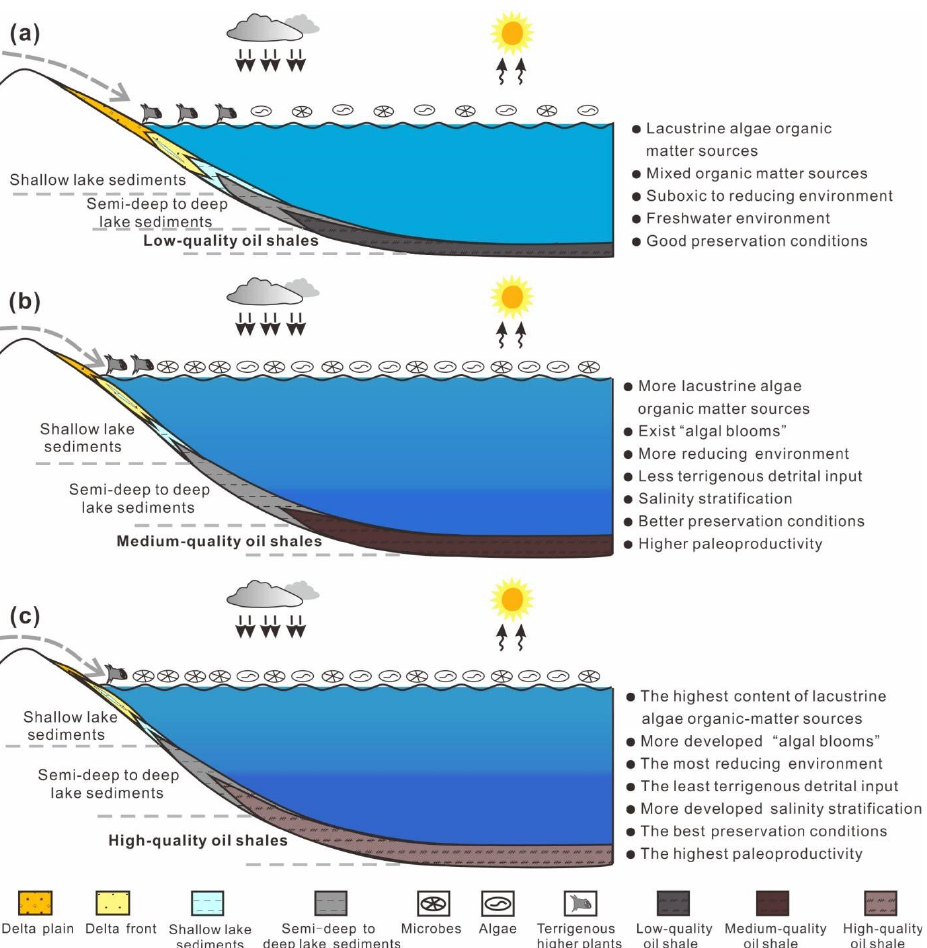
Figure 12. Organic matter enrichment models for the different quality oil shales in the Shale Member of Shimengou Formation. ( a ) organic matter enrichment model of low-quality oil shale; ( b ) organic matter enrichment model of medium-quality oil shale; ( c ) organic matter enrichment model of high-quality oil